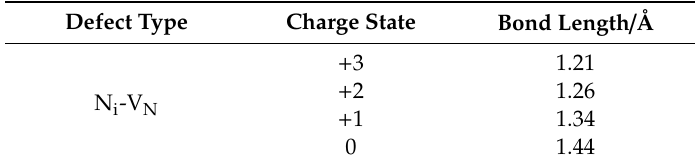
Table 3. Bond lengths of N i in the nearest N i -V N for di ff erent charge states.